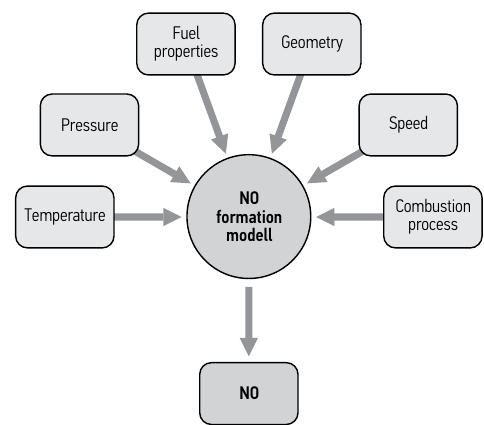
Fig. 2. The structure of the model ( source : own edition)